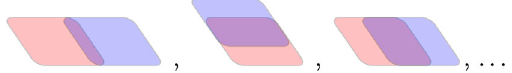
FIG. 3. Examples of subsystems for which the relation S ð AB Þþ S ð BC Þ − S ð B Þ − S ð ABC Þ ¼ 0 holds, assuming Eq. (1). The color convention is red for A , purple for B , and blue for C